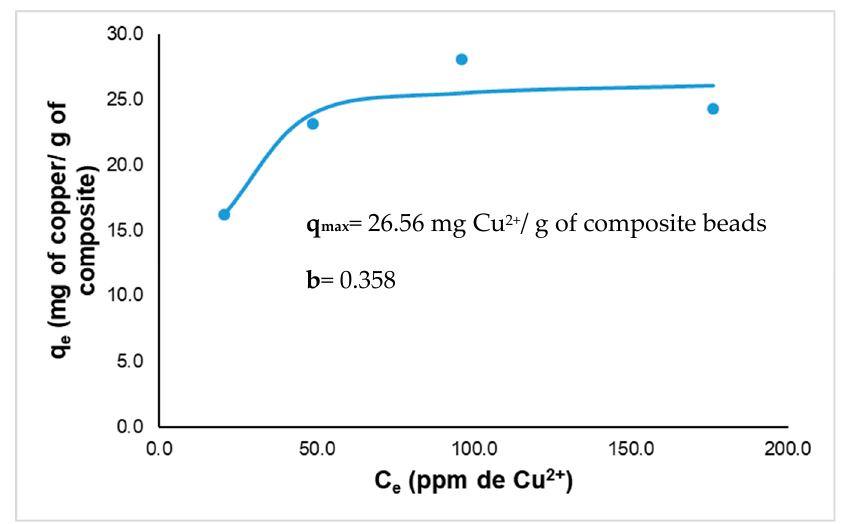
Figure 5. Equilibrium adsorption isotherm using the Langmuir model.